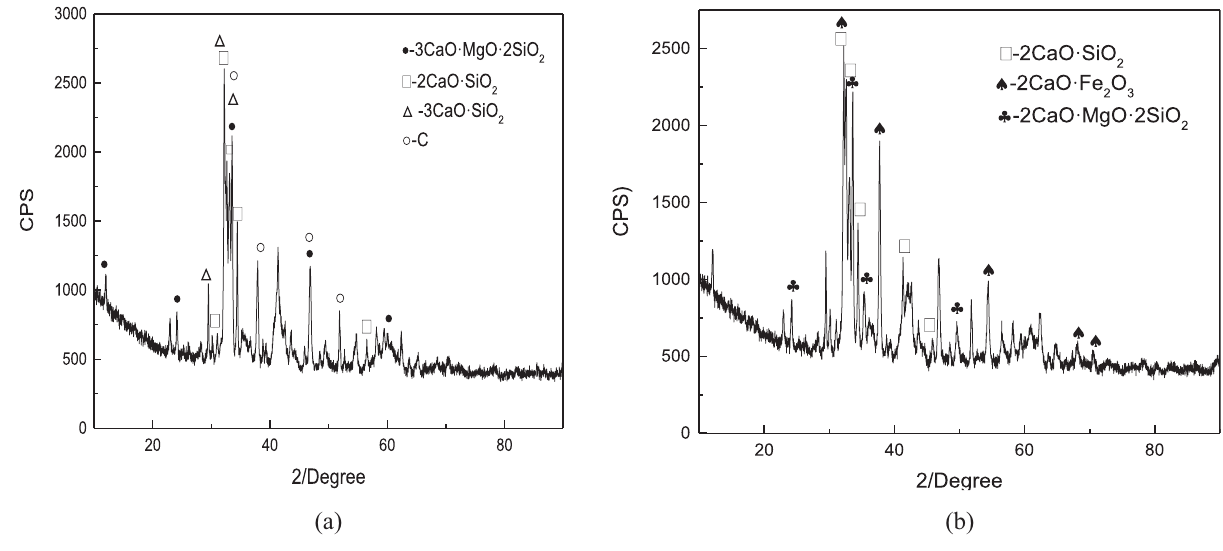
Figure 14: The results of XRD detection. ( a ) XRD results 1, ( b ) XRD results 2.